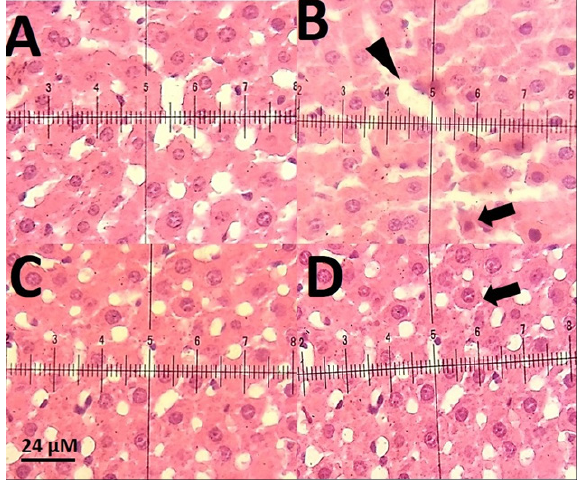
Figure 5. (A): Light micrograph of a liver section of a control rat; normal hepatocyte (arrow) and normal hepatic architecture. (B): Light micrograph of a liver section of rats treated with Se powder (0.4 mg/kg). Hepatitis (arrow point), cytoplasmic vacuolation (arrow), and disarrangement of hepatic cords. (C): Liver section of a rat treated with Se NCs (0.4 mg/kg). Normal hepatocytes (arrow). (D) Liver section of a rat treated with Se NPs (0.4 mg/kg). Normal hepatocyte (arrow) (PAS stain. Mic. Mag. ×